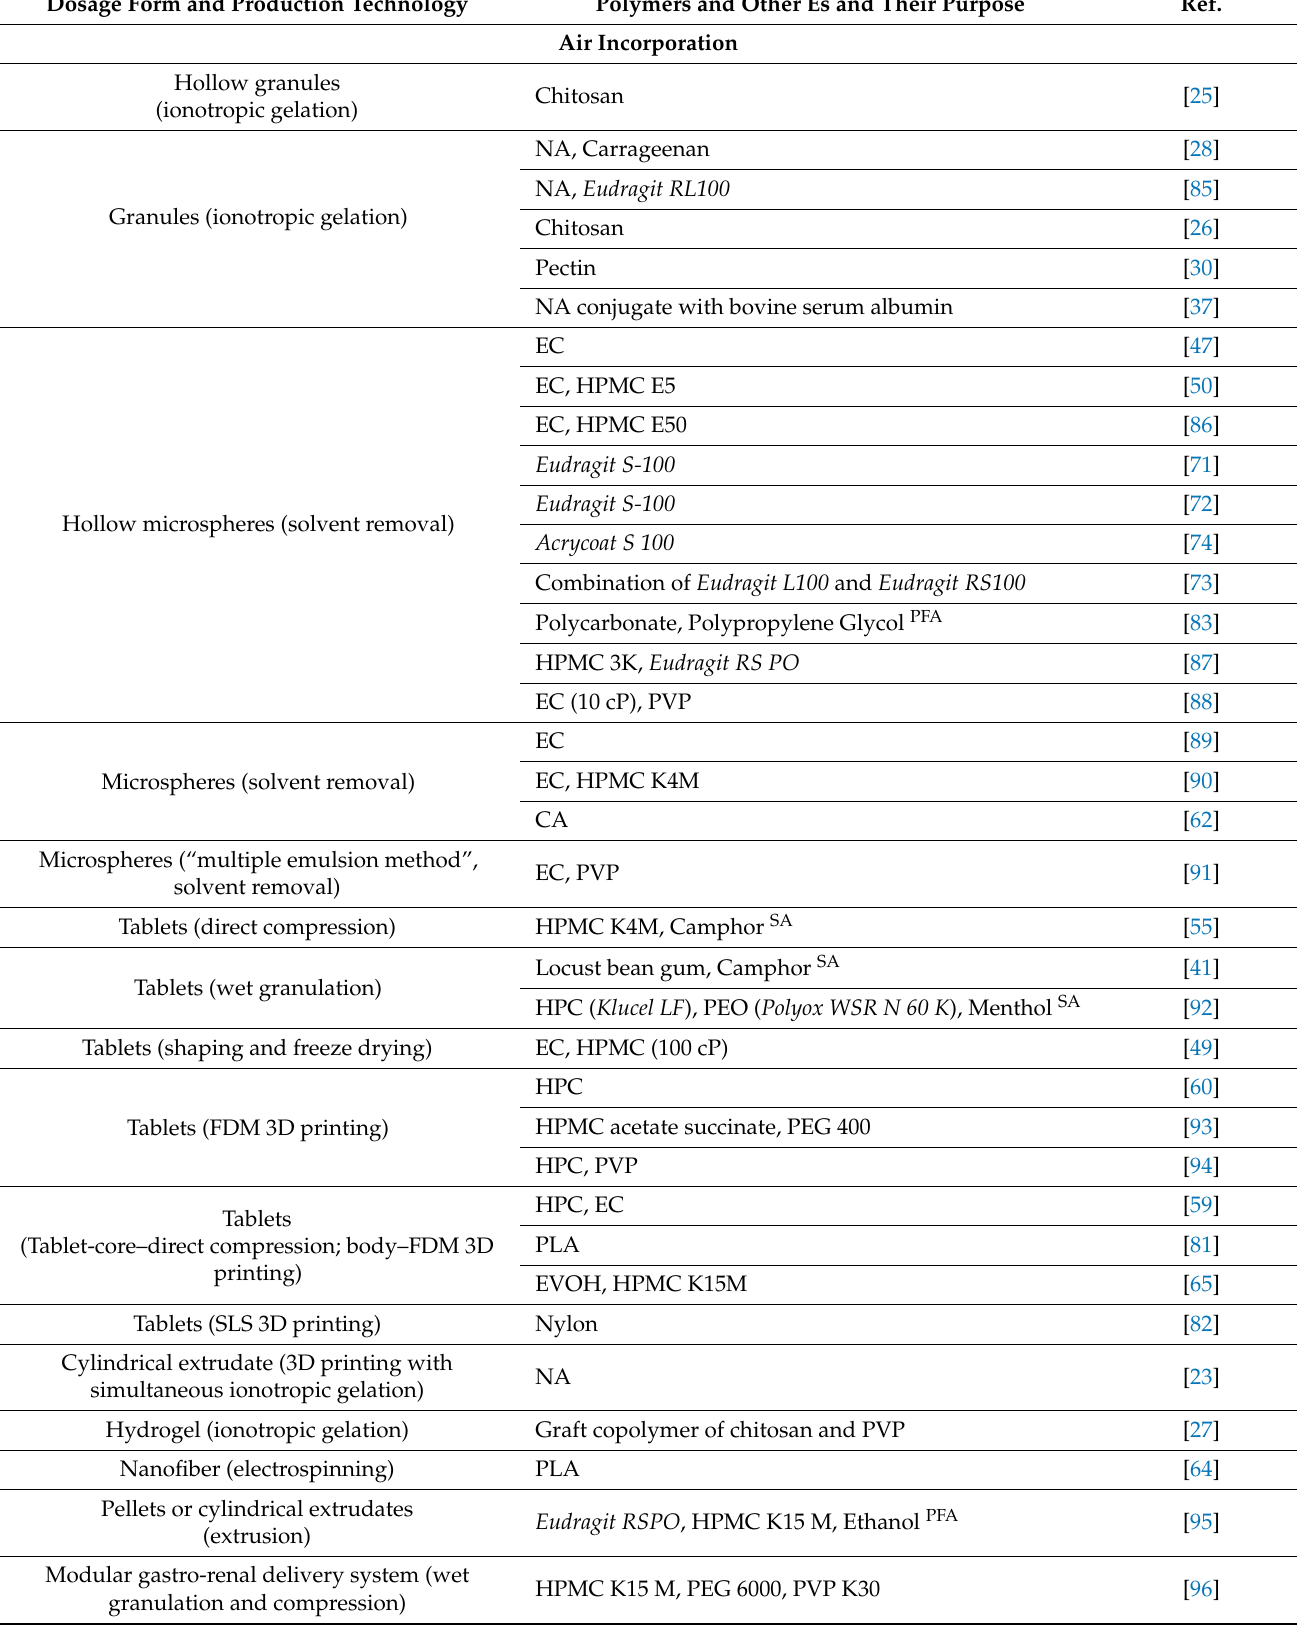
Table 1. Examples of the use of various polymers in the field of obtaining floating drug delivery systems. Dosage Form and Production Technology Polymers and Other Es and Their Purpose